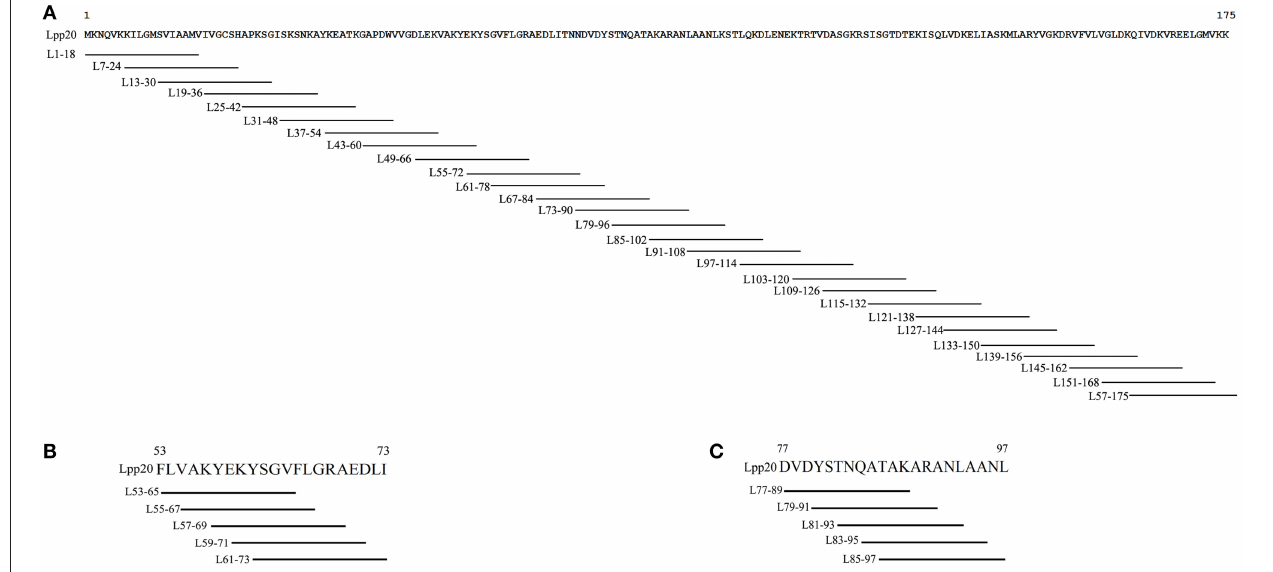
FIGURE 1 | The schematic diagram of 18mer and 13mer overlapping peptides covering Lpp20 protein (A) 18mer synthetic peptides that covered the whole Lpp20 protein and overlapped by 12 amino acids. (B) Various N- and C-terminus extended or truncated 13mer peptides were based on initially identified dominant 18mer L 55 – 72 and overlapped by 11 amino acids. (C) Various N- and C-terminus extended or truncated 13mer peptides were based on initially identified dominant 18mer L 79 – 96 and overlapped by 11 amino